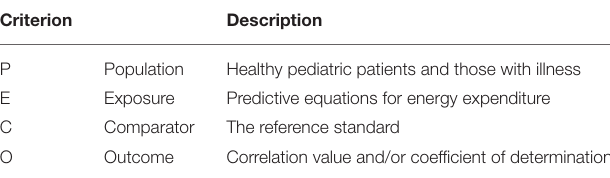
TABLE 1 | PECO criteria for study